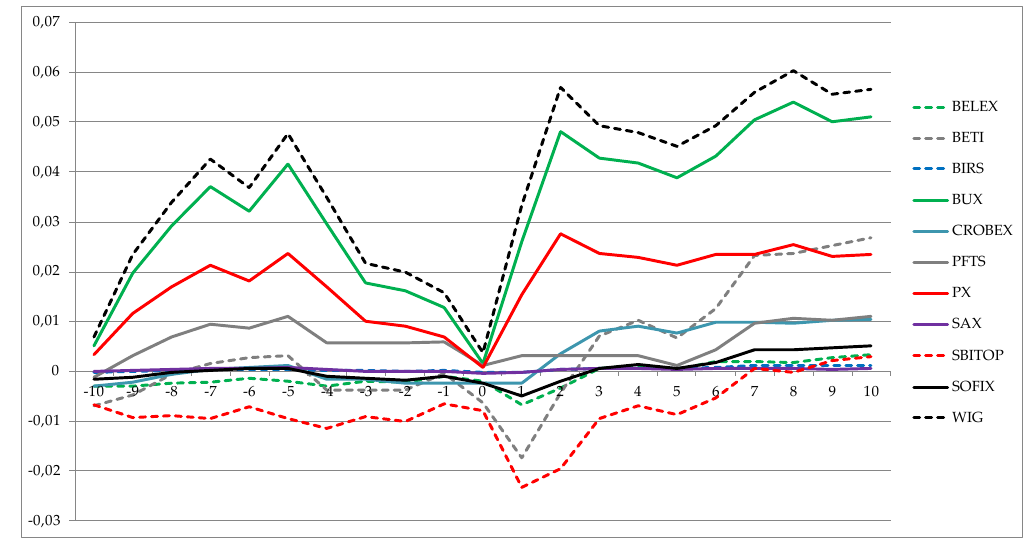
Figure A1. Individual CAR s, CEE regional market factor.